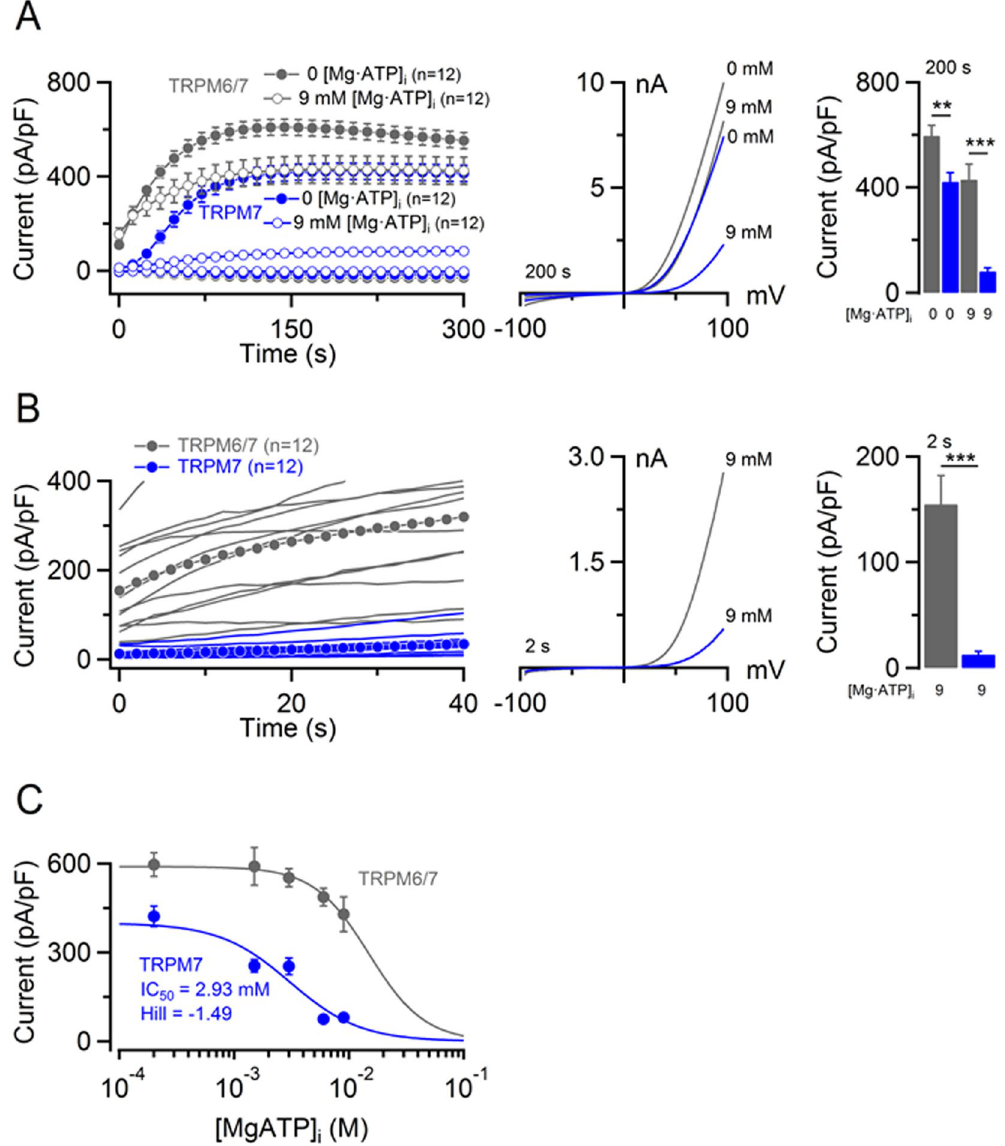
Figure 9. Sensitivity of mTRPM6/7 currents to cytosolic Mg·ATP. ( A ) Left panel: Whole-cell currents measured in mTRPM7 (blue) and mTRPM6/7 (grey) transfected HEK 293 cells using internal solutions containing 9 mM [Mg·ATP] i and 250 µ M free [Mg 2 + ] i (open dots) or only 250 µ M free [Mg 2 + ] i (closed dots). Current amplitudes (mean ± SEM) were acquired at − 80 and + 80 mV and plotted over time. Middle panel : Representative I-V relationships (at 200 s) of currents shown in the Left panel . Right panel: Bar graphs of outward currents ( − 80 mV) shown in the Left panel . ( B ) Magnification of currents illustrated in (A). Left panel: Outward current amplitudes (at + 80 mV) acquired from individual cells with the corresponding means (dots). Middle panel : Representative I-V relationships of currents (at 2 s) shown in the Left panel . Right panel: Bar graphs of outward currents (mean ± SEM) at + 80 mV in the Left panel . n, number of cells measured; ** P < 0.01; *** P < 0.001 (two-tailed t-test). ( C ) Dose-dependent inhibition of mTRPM7 (blue) and mTRPM6/7 (grey) currents ( + 80 mV, 200 s) by [Mg·ATP] i (250 µ M free [Mg 2 + ] i ). Measurements (n = 9–12 cells per concentration) were performed as in